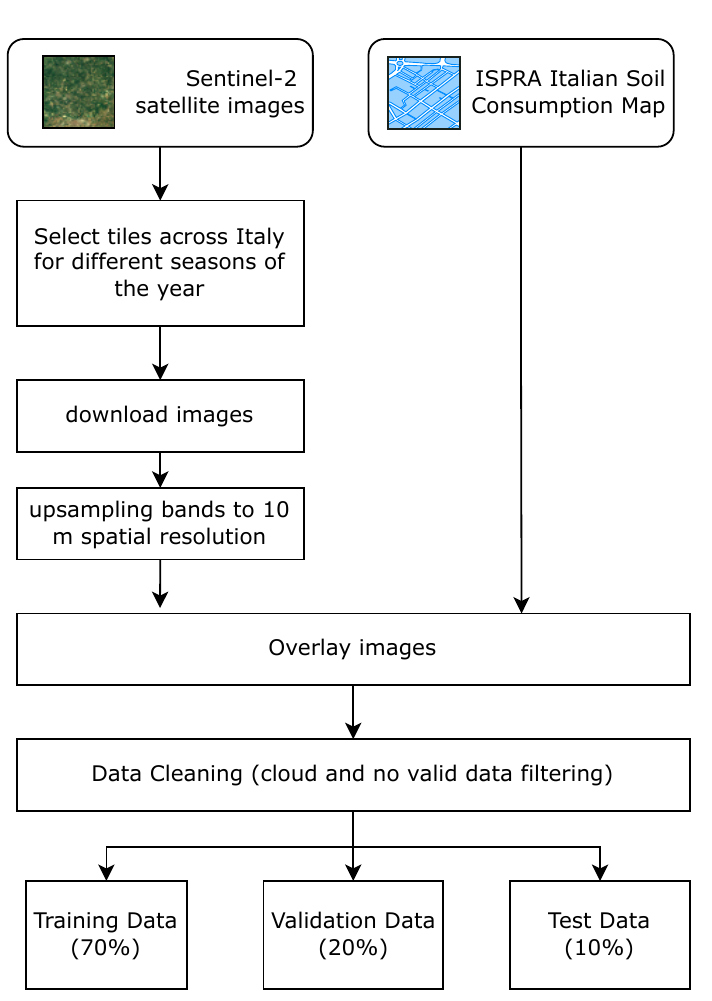
Figure 4. Schematic representation of the impervious surface dataset